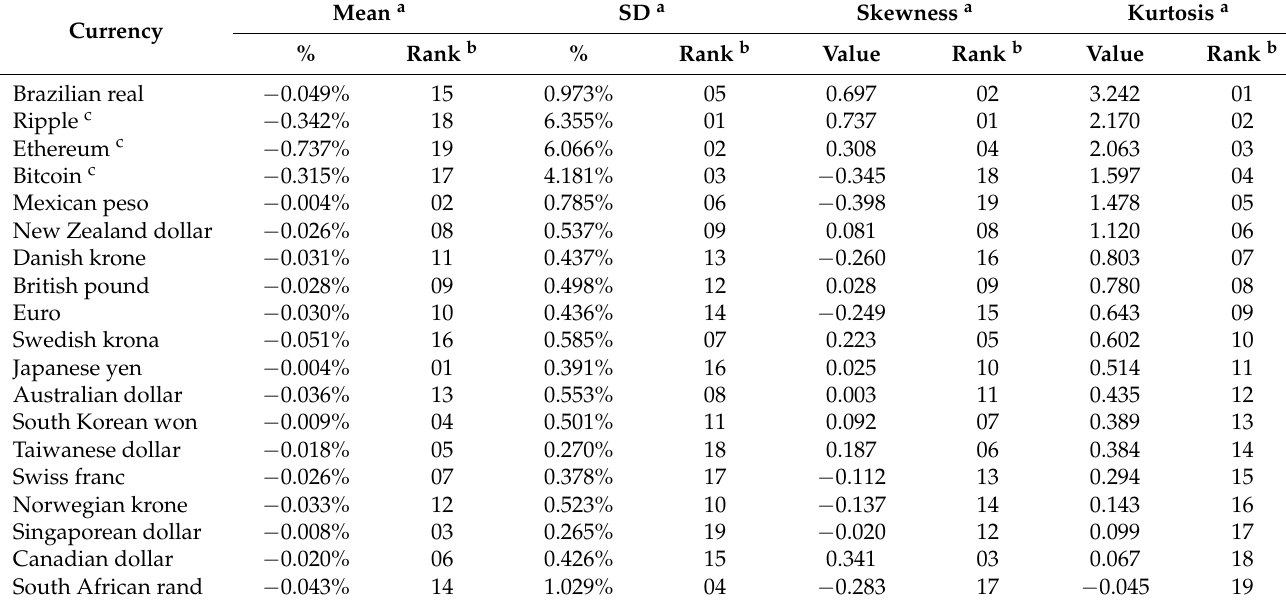
Table 1. Depreciation rates, descriptive statistics.